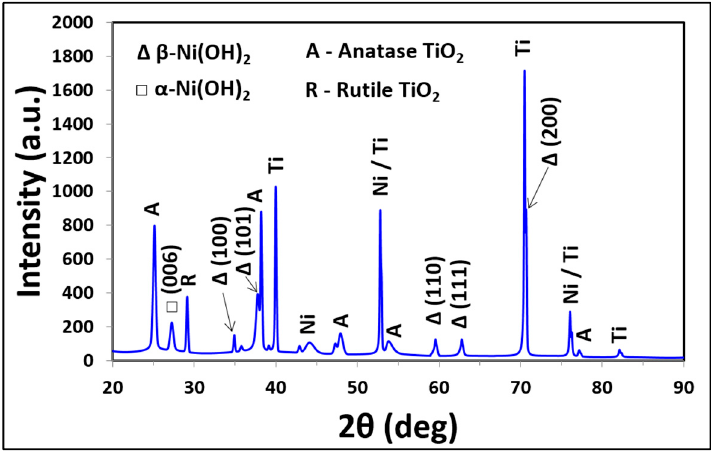
Figure 3. XRD pattern of Ni-TNA with 2 θ ranging from 20° to 90°.